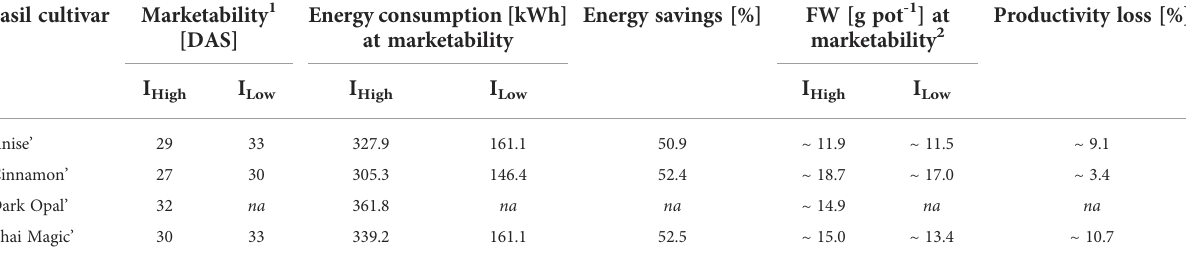
TABLE 9 Energy consumption and biomass at marketability of four Ocimum basilicum L. cultivars grown under two different light intensities. Basil